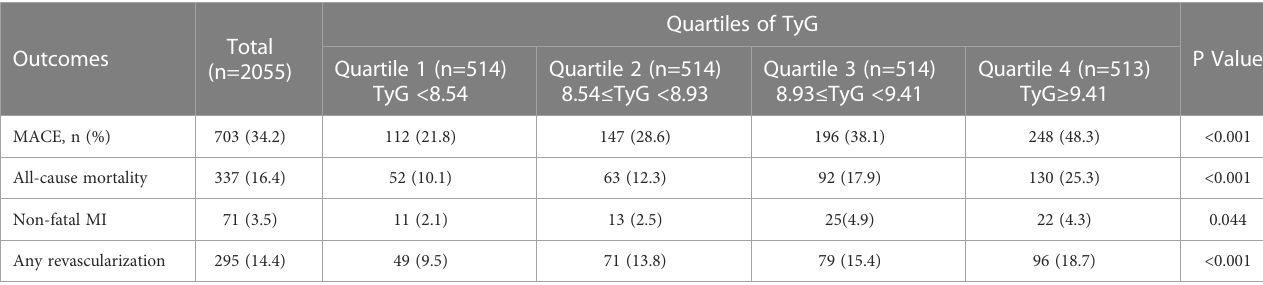
TABLE 2 Outcomes of patients strati fi ed by TyG